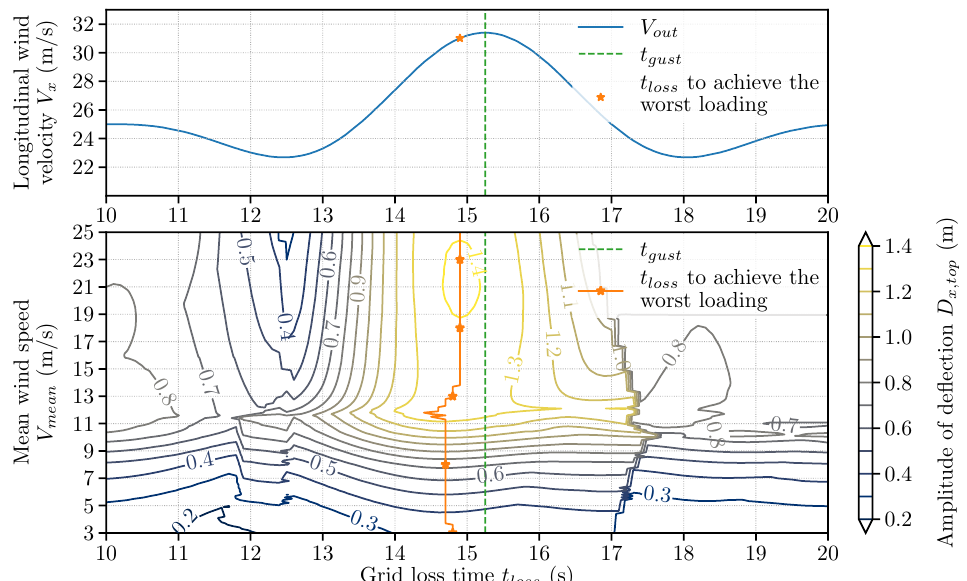
Figure 8. Grid loss timing in the range of operating wind speed with reference to tower deflection. The upper line plot gives an example of wind speed of gust at mean wind speed V mean = V out = 25m/s. The lower contour plot shows the peak-to-peak amplitude in relation to the mean wind speed V mean and the grid loss time t loss